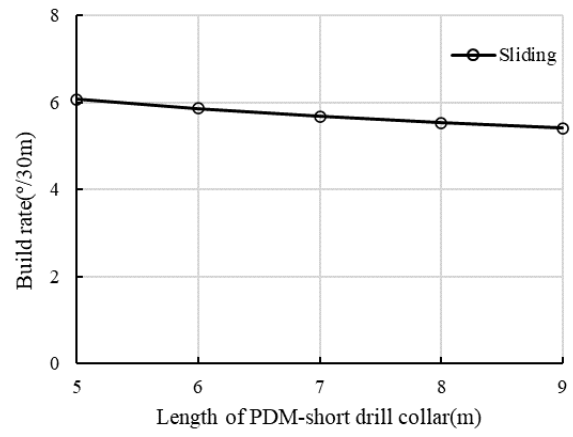
Fig. 20. Sliding Build rate VS length of PDM-short collar